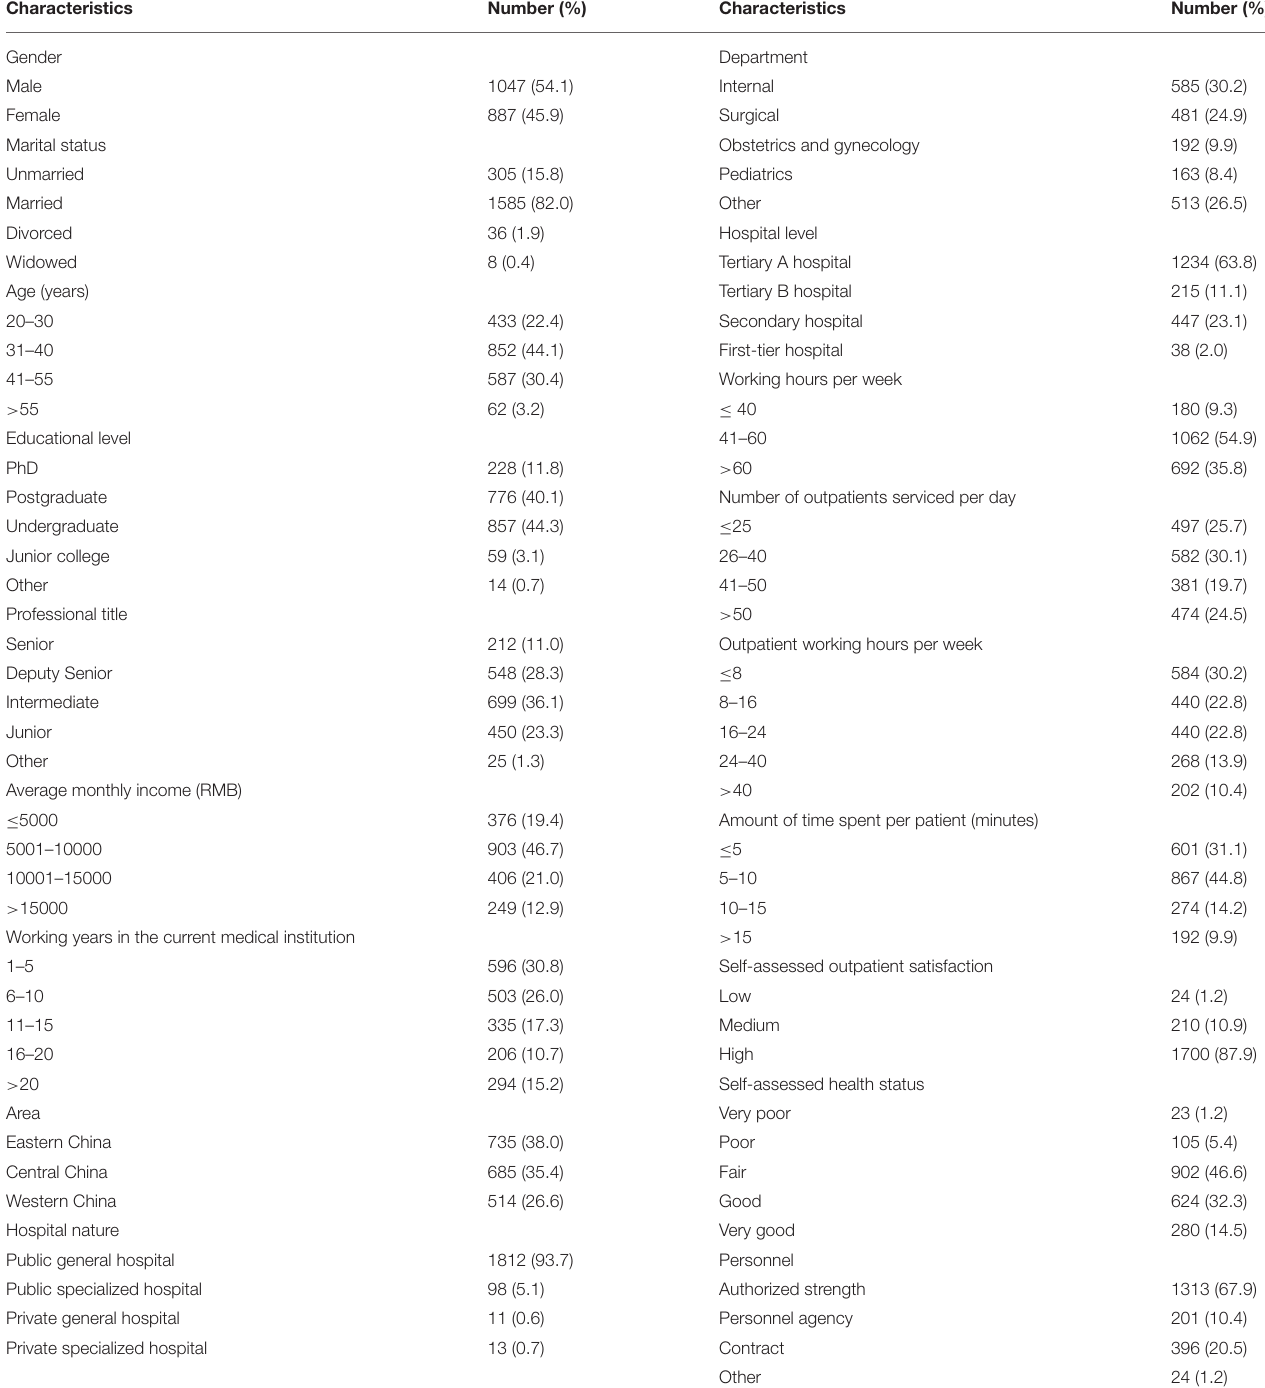
TABLE 1 | Detailed demographic characteristics of the 1934 participating